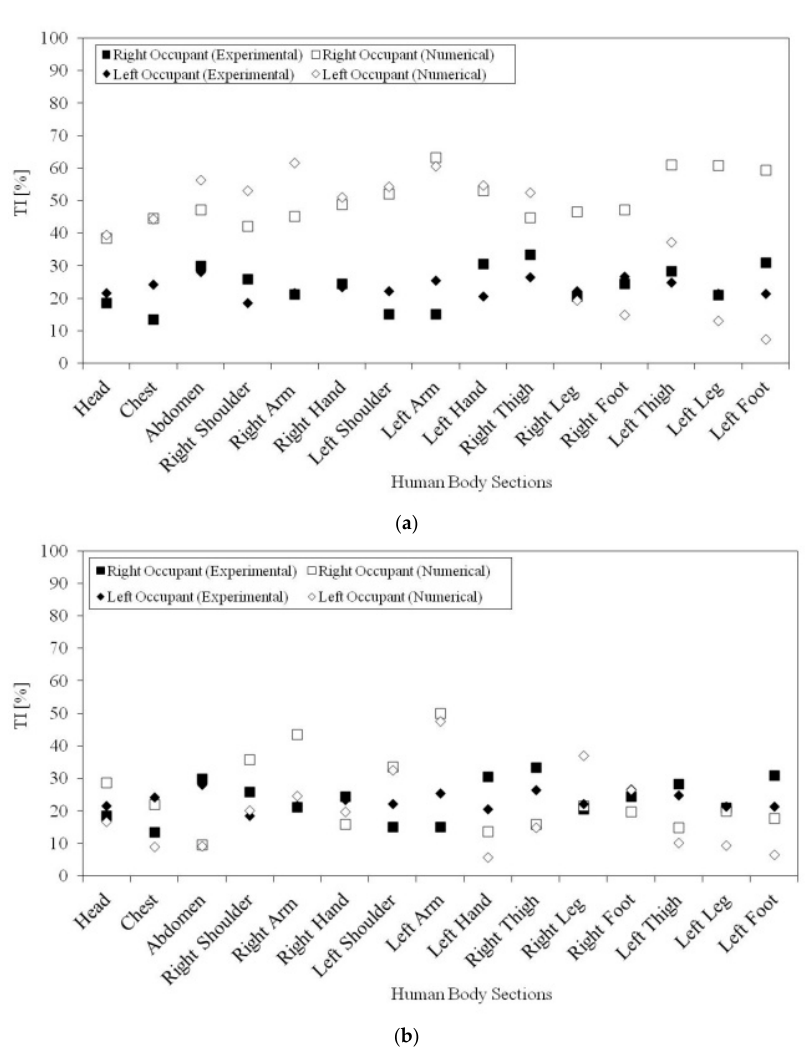
Figure 9. Air turbulence intensity (TI) around the occupants, numerically calculated and experimentally measured. In ( a ), the k ‐ epsilon turbulence model is used, and in ( b ), the RNG turbulence model is applied.